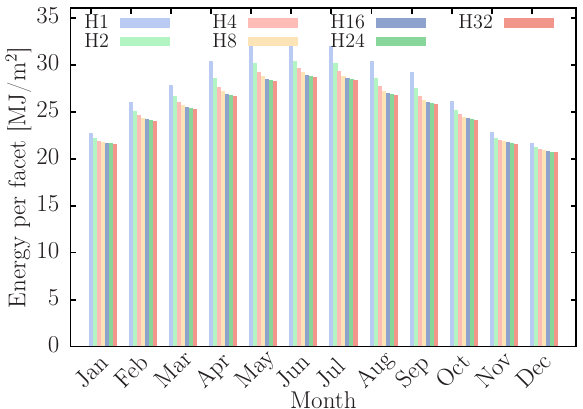
Figure 12. Energy contributed per mirror throughout the year for different arrays. Distance of 0.75 h (26.25